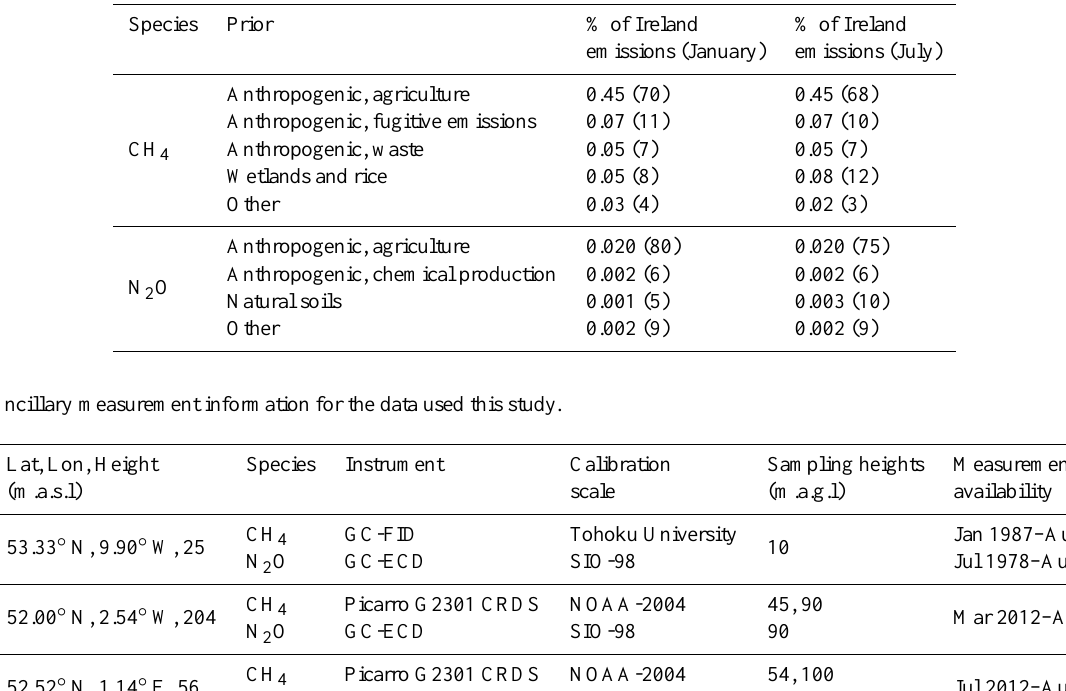
Table 4. A priori emissions of major source sectors in Tgyr − 1 and percent contribution to Ireland emissions.